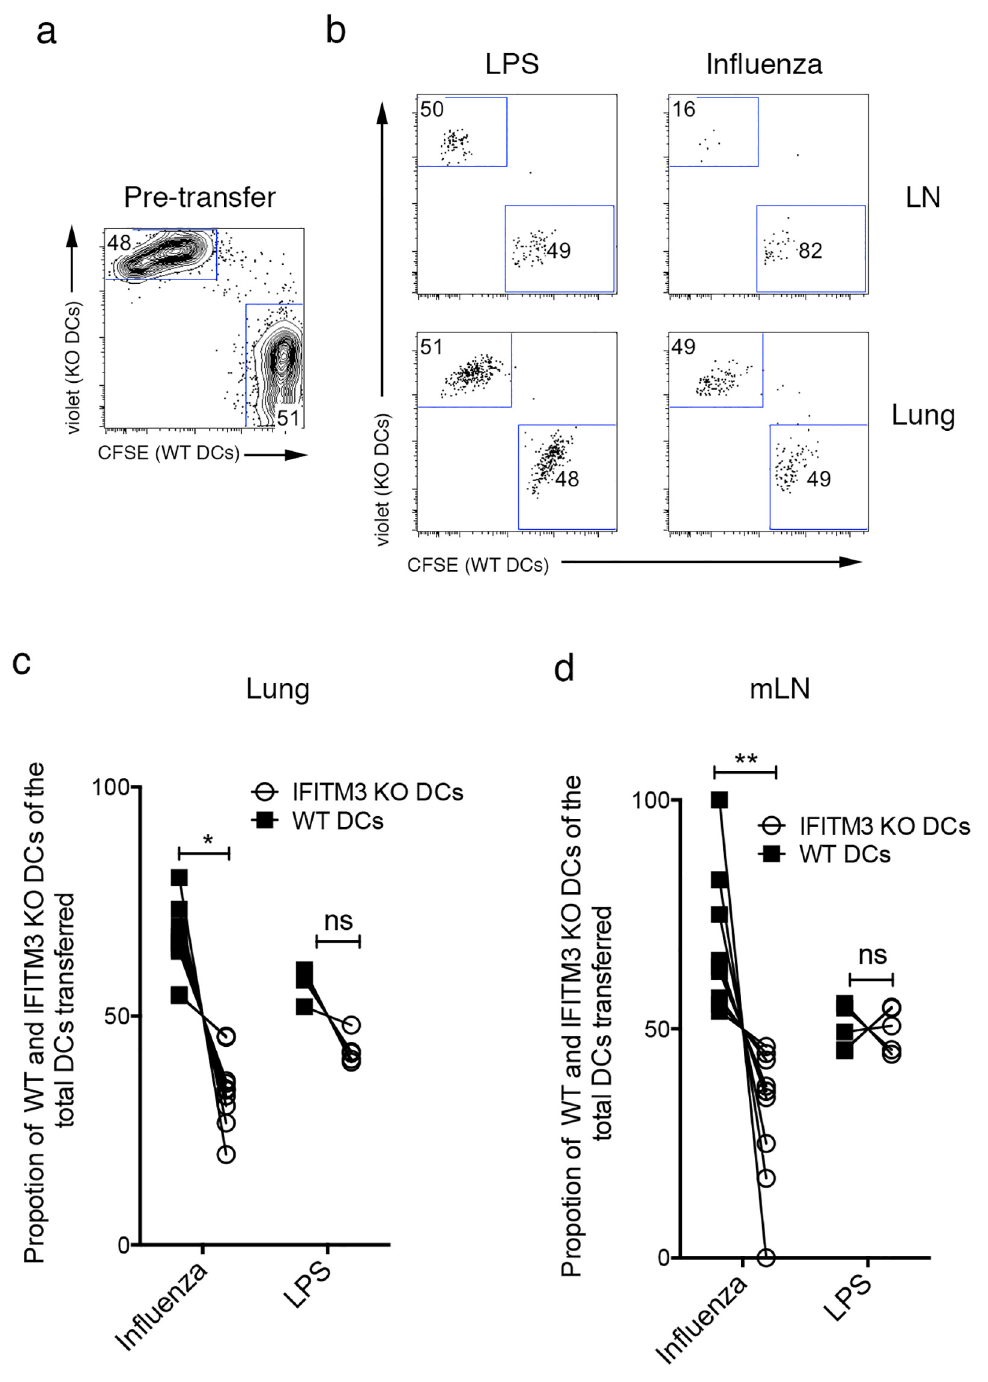
Fig 5. Impaired IFITM3 KO DC trafficking after intranasal instillation into the airway of influenza virus infected mice. B6 mice were infected with 10 4 PFU of IAV (x31) and 24 hrs later received instranasally one million violet dye labeled IFITM3 KO and one million CFSE labeled WT DCs. A 1:1 ratio of DCs were also administered into control mice that were na ï ve and received LPS at the time of DCs immunization. Two days after DC administration the ratio of B6 and IFITM3 KO DCs in the lung and lung draining LN of the influenza virus infected and LPS treated mice was determined. (a) Representative flow cytometry profiles depicting the ratio of IFITM3 KO and WT DCs pre transfer and (b) 48hrs after transfer in the lung and LN. Profiles are gated on the adoptively transferred cells. The proportion of IFITM3 KO and WT DCs of the total DCs transferred in the (c) lung and (d) LN 48hrs after transfer into influenza infected or LPS treated mice. Lines join individual mice. ( n = 5 – 10 mice per group, data pooled from 3 independent experiments, Student ’ s t-test ** P < 0.01).